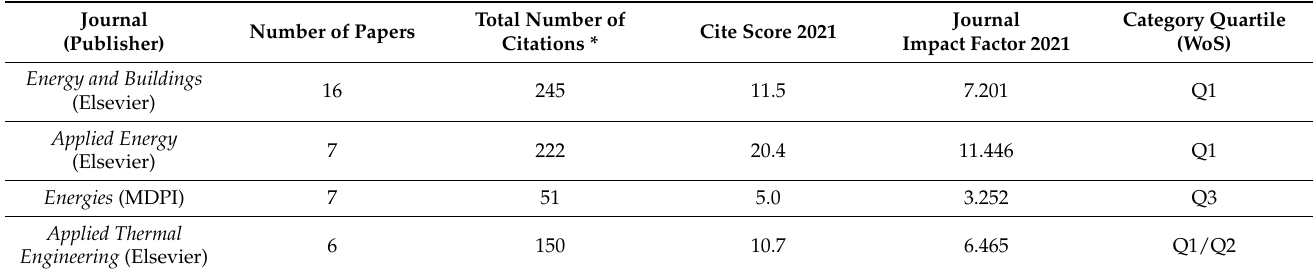
Table 6. The most productive journals in greywater energy recovery domain.